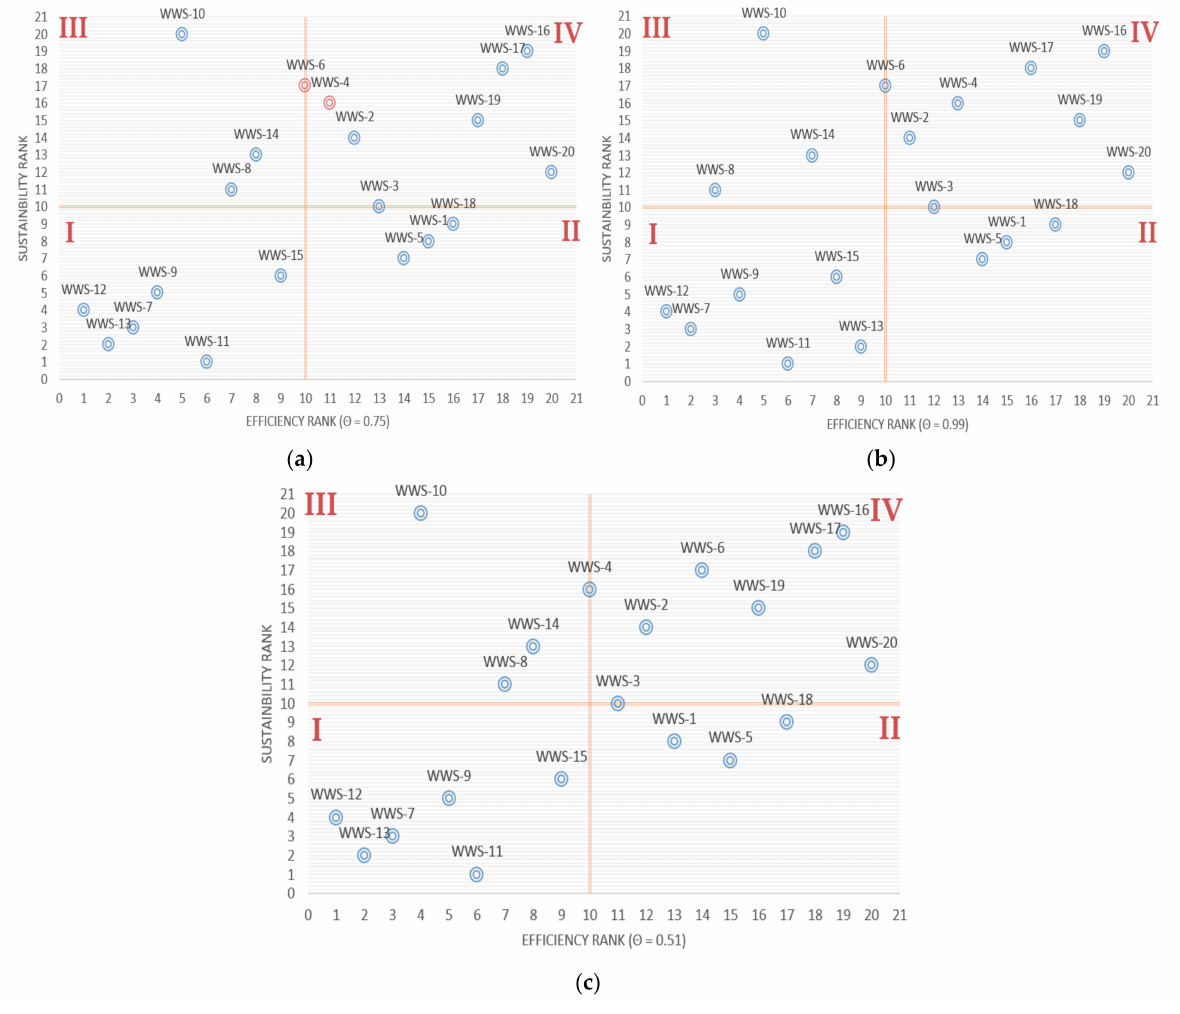
Figure 7. Positioning maps of WWS locations: ( a ) Under moderate importance degree toward gains; ( b ) Under high importance degree toward gains; ( c ) Under low importance degree toward gains. Table 9. Location classification for